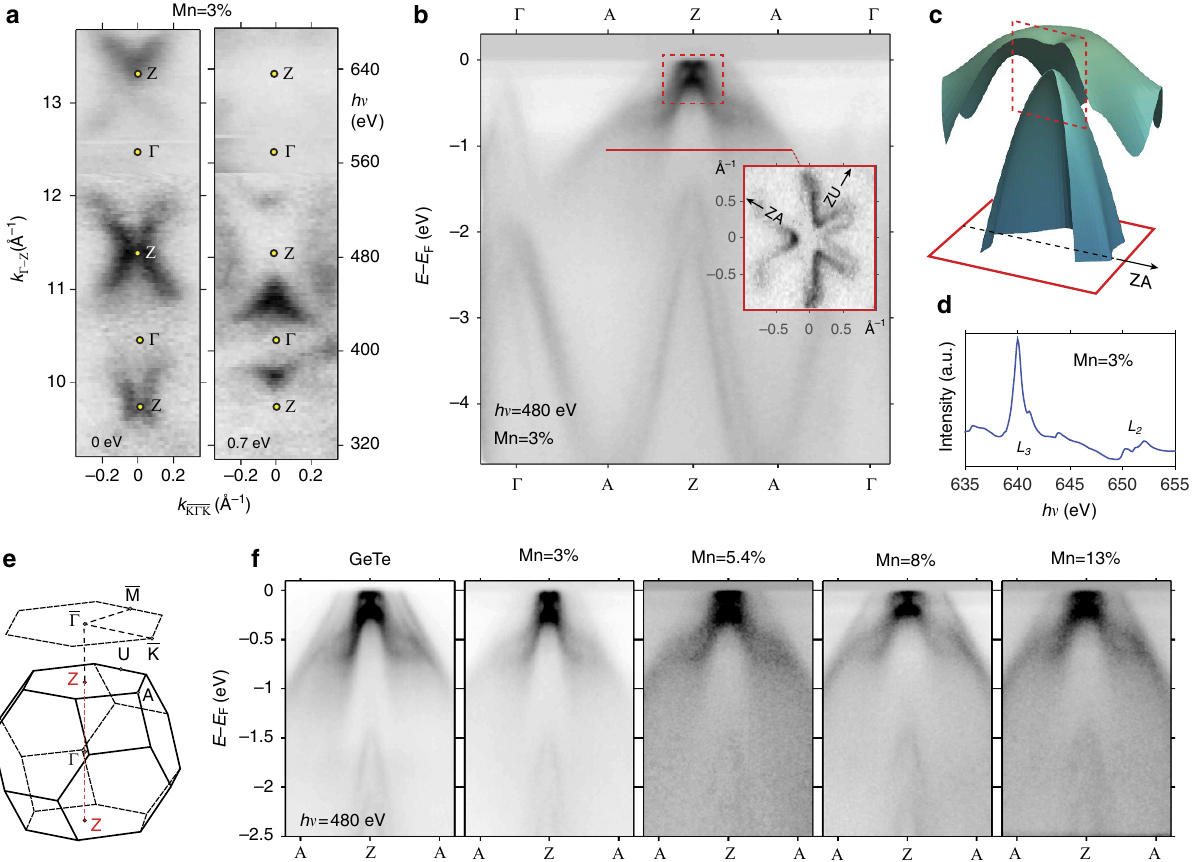
Figure 2 | Soft X-ray ARPES data. ( a ) SX-ARPES photon-energy dependent constant binding-energy maps of the Ge 0.97 Mn 0.03 Te valence band bulk states near Fermi level and at 0.7eV binding energy in the K G K plane. ( b ) SX-ARPES band map measured along Z–A– G with theoretical band plots in c to compare with measured data near E F . The inset is a constant binding energy map at 1eV binding energy. ( d ) X-ray absorption data near the L 3 absorption edge. ( e ) Brillouin zone of quasicubic GeTe. ( f ) ARPES band maps along A–Z–A for the selected Mn dopings. The dashed rectangle in b zooms into region near E F where the Zeeman gap opening is